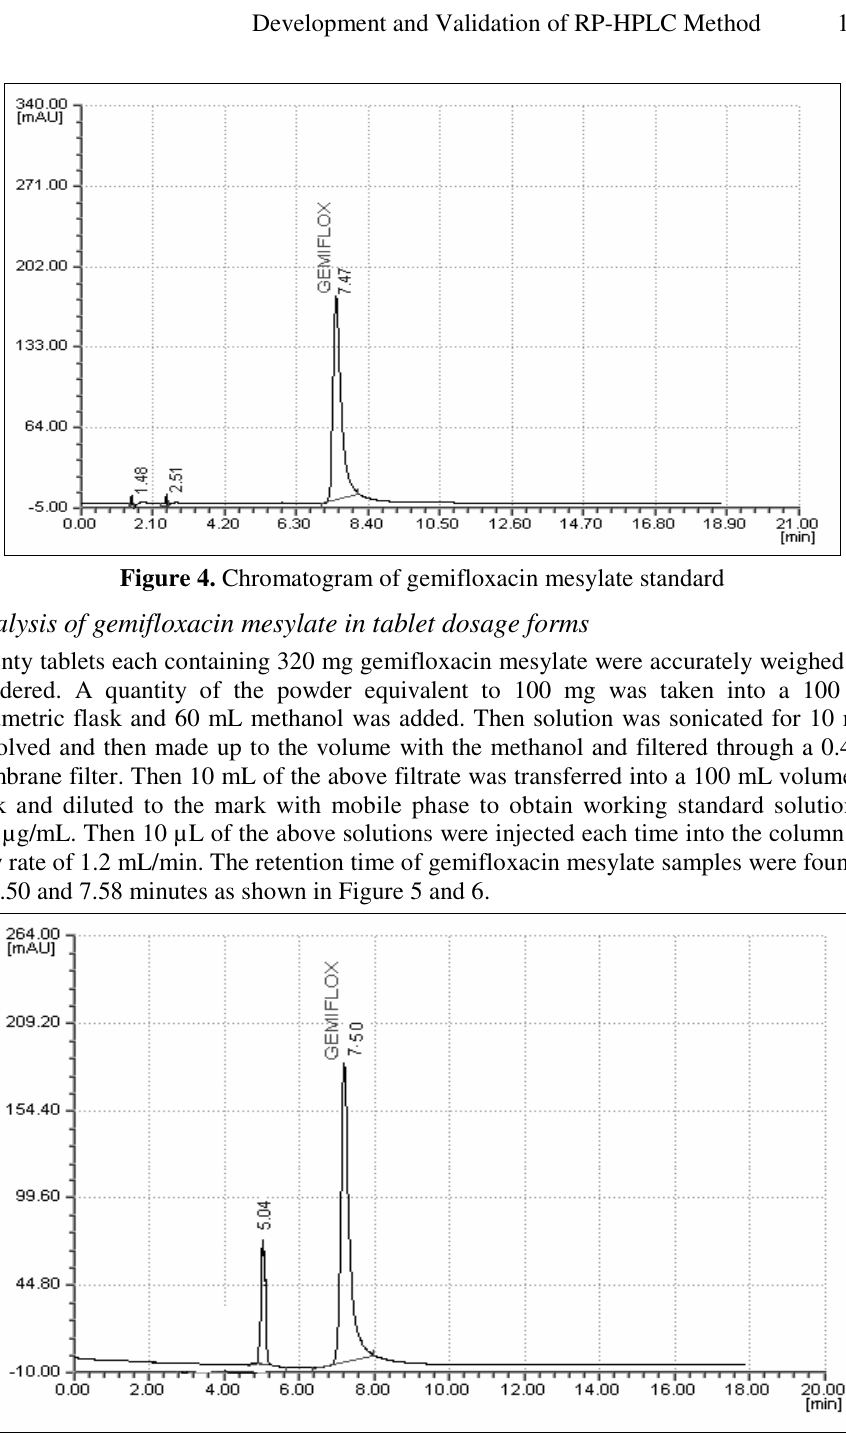
Figure 5. Chromatogram of gemifloxacin mesylate sample 1 (in